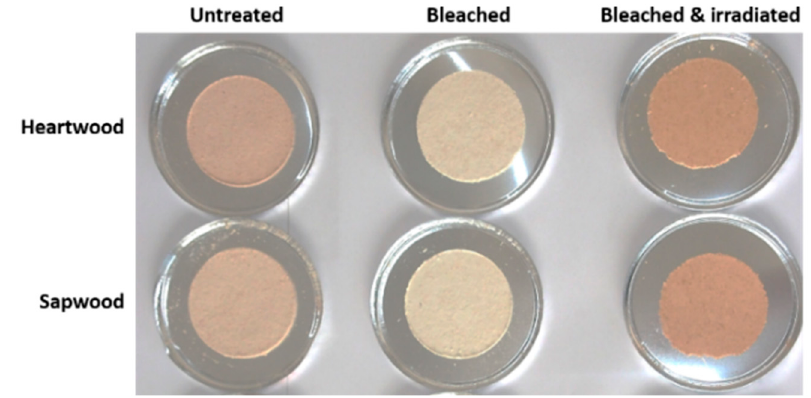
Figure 13. Comparison of untreated, bleached, and irradiated/bleached samples